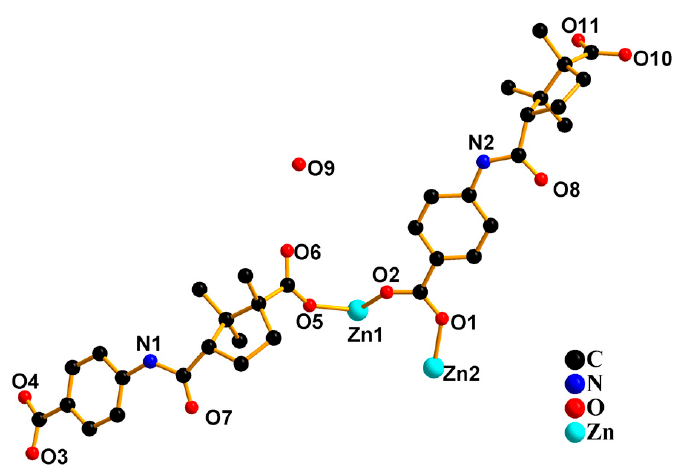
Figure 1. Asymmetric unit of JUC-112. The hydrogen atoms have been omitted for clarity.